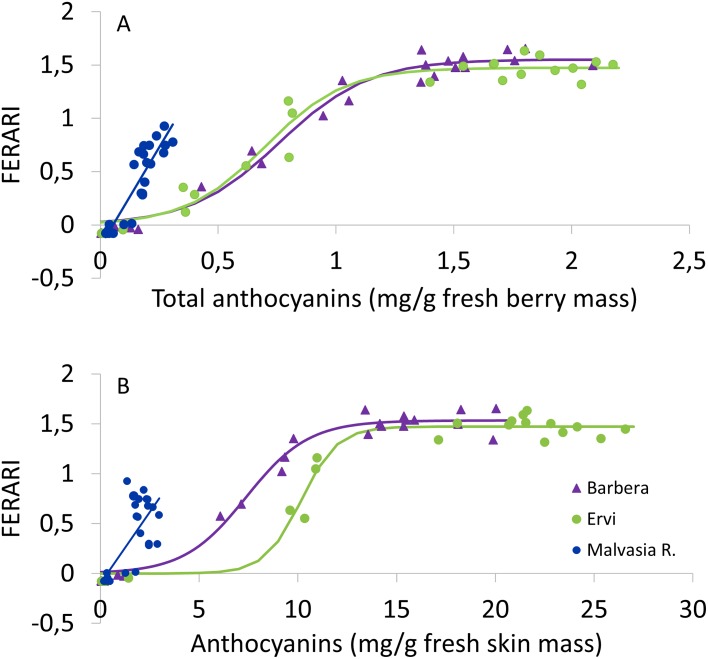
Correlation between seasonal field recorded FERARI index and the Anth concentrations determined by wet chemistry in three red cultivars with Anth given on a berry fresh basis (A) and a skin fresh basis (B).In panel A, data taken on the low color-accumulating Malvasia R. fitted to the following linear model: y = 3.7167X − 0.1982, R2 = 0.84. Data taken on Barbera and Ervi were instead fitted to the following sigmoid models: y = 1.55/(1+EXP(4.005–5.261x)), R2 = 0.99, n = 27 (Barbera) and y = 1.47/(1+EXP(4.132–5.906x)), R2 = 0.97, n = 27 (Ervi). In panel B, Malvasia R. data were fitted to the following linear model: y = 0.313x − 0.1403, R2 = 0.64, n = 27. Sigmoid models run through Barbera and Ervi data sets were: y = 1.533/(1+EXP(4.690–0.635x)), R2 = 0.99, n = 27 (Barbera) and y = 1.471/(1+EXP(11.064–1.088x)), R2 = 0.98, n = 27.